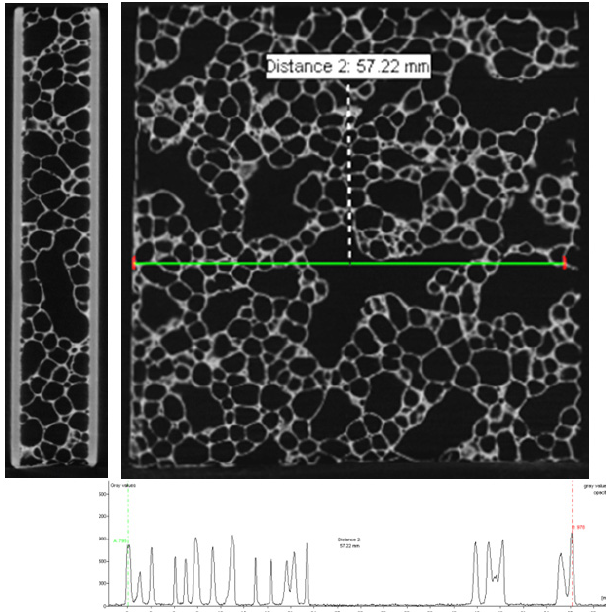
Figure 4: CT analysis of an honeycomb panel ( d =3 mm). Figure 5: CT analysis of an AFS Schunk panel.